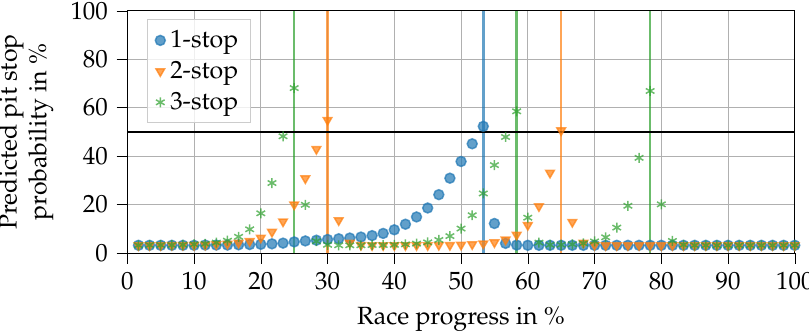
Figure 10. Progressions of pit stop probability predictions in an exemplary race when varying the intended number of pit stops as outputted by the final trained hybrid NN. The vertical lines indicate a pit stop that was actually performed. The horizontal line at a 50% probability level separates the no pit stop from the pit stop